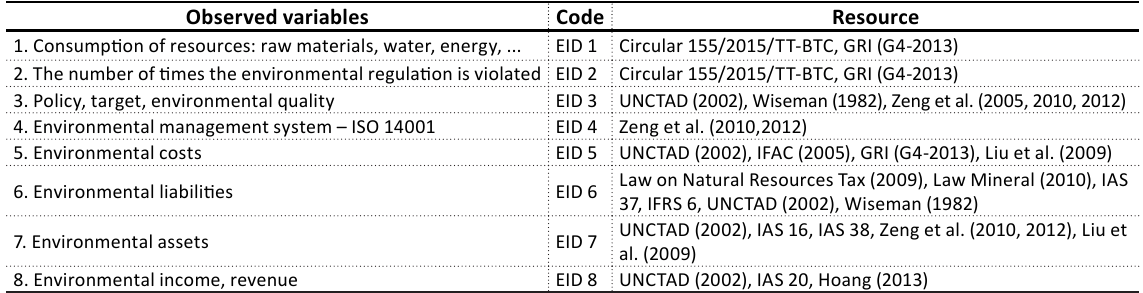
Table 1. Observed variables measuring the level of environmental information